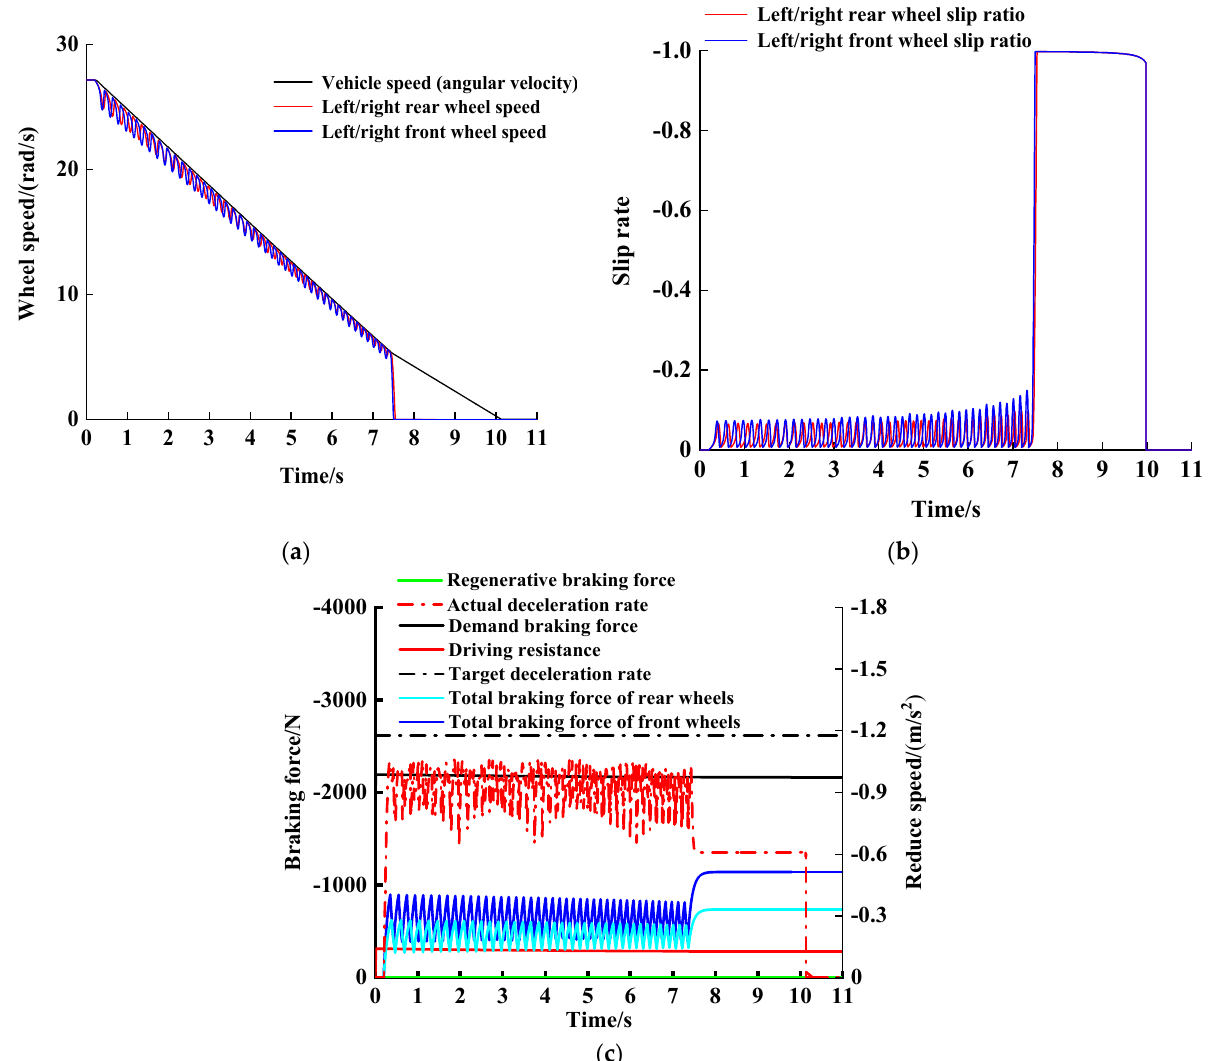
Figure 10. The simulation results of low adhesion road surface. ( a ) Speed. ( b ) Slip rate. ( c ) Braking force distribution.